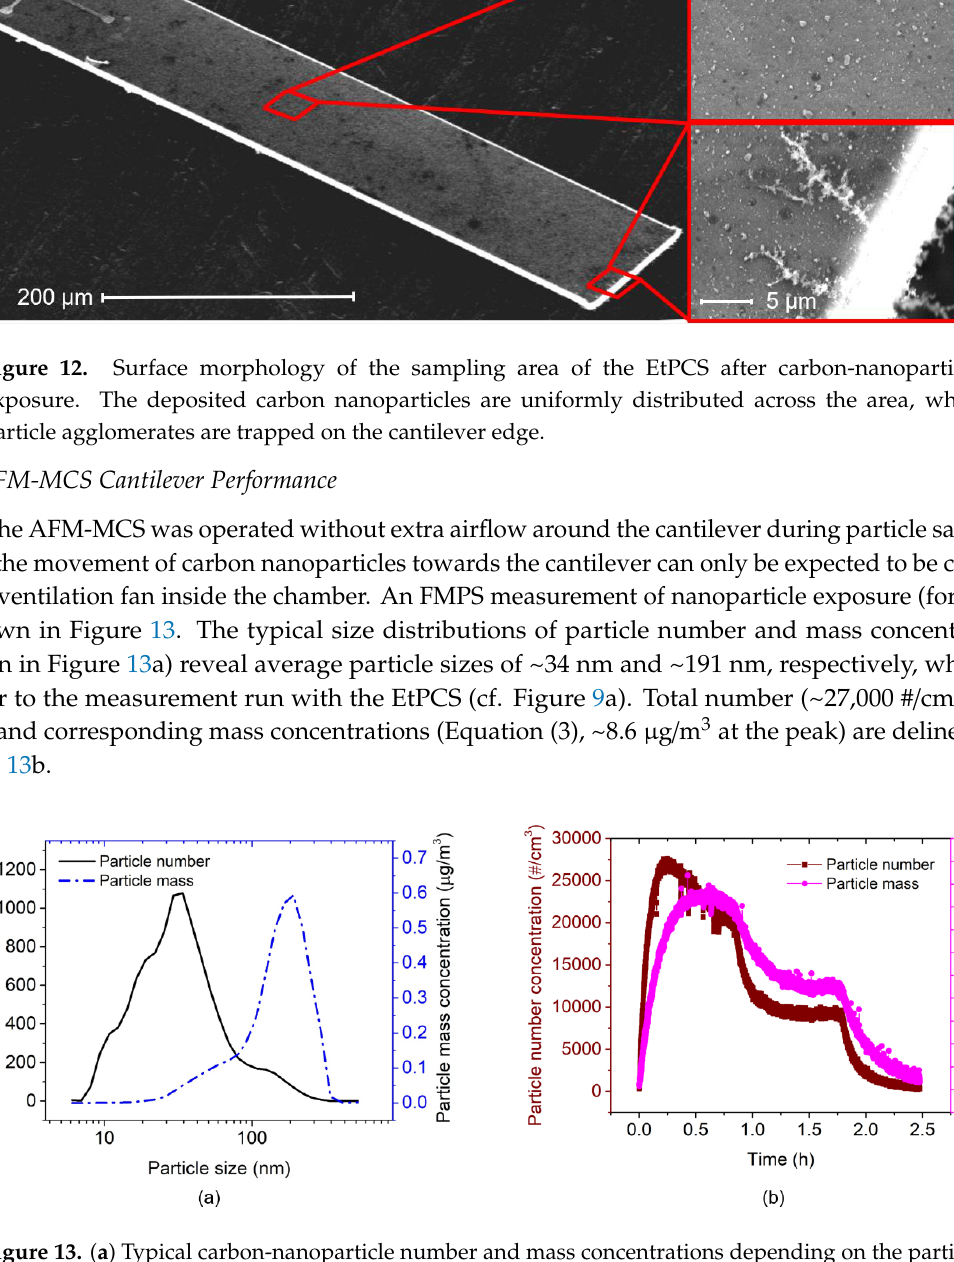
Figure 11. ( a ) Carbon nanoparticle mass concentration measured by the EtPCS (full blue circles) in comparison with FMPS (full black line). ( b ) The frequency stability measurement under a temperature of 22.3 ± 0.4 °C and relative humidity of 23 ± 1%. The inset shows an exemplary detail enlargement of the frequency tracking within 10 min showing σ ≈ 27 mHz.